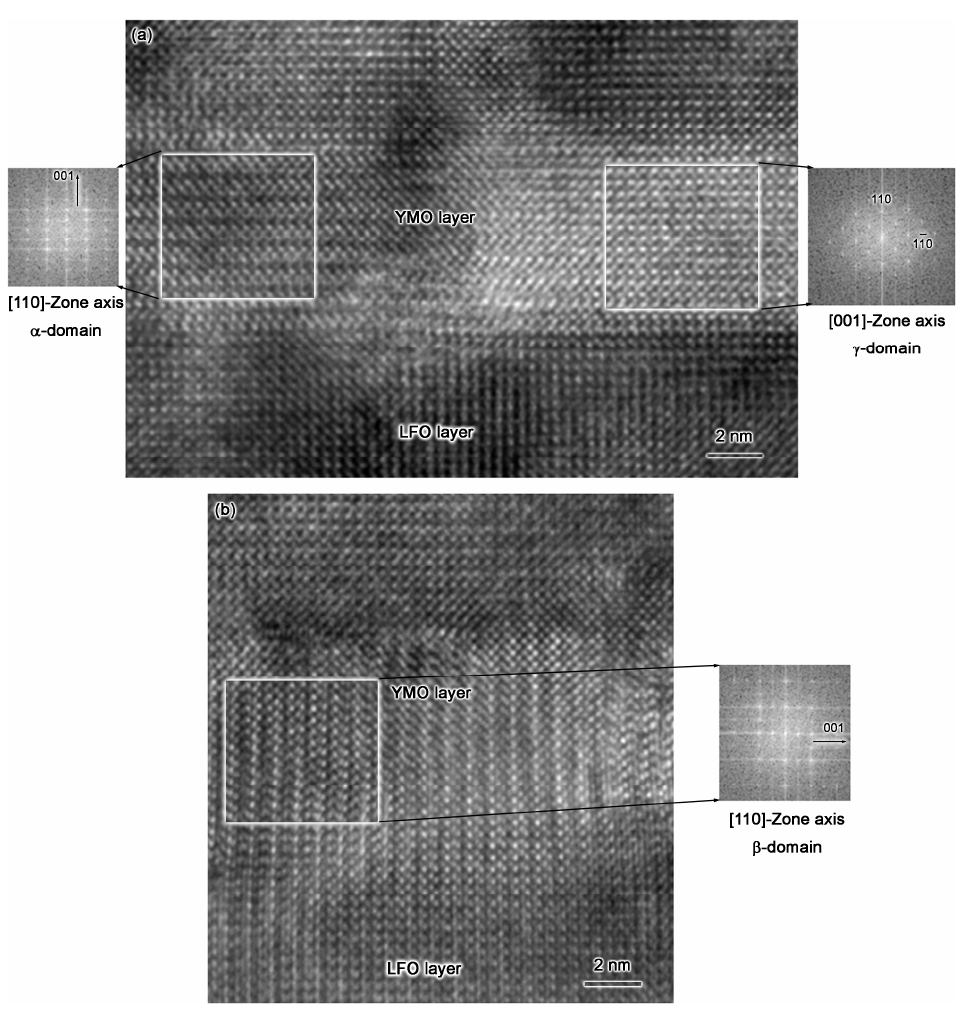
Figure 3. ( a , b ) are two typical High-resolution TEM (HRTEM) images of sample-I show that there are multi-domain structures in YMO layers. Three digital Fast Fourier Transformation (FFT) images are depicted in these pictures, as well. The areas used to take FFT images are highlighted by white squares. Obviously, overlapping of three FFT images forms the same pattern as that shown in Figure 1b.